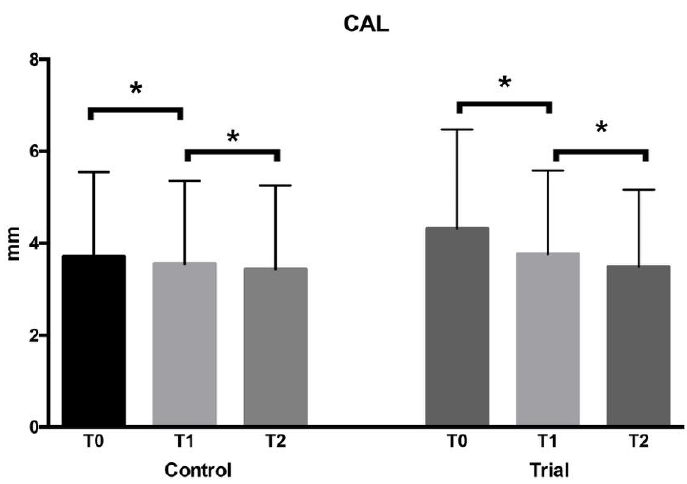
Figure 3. CAL values among the time frames of the study. * = p < 0.05. ns = not